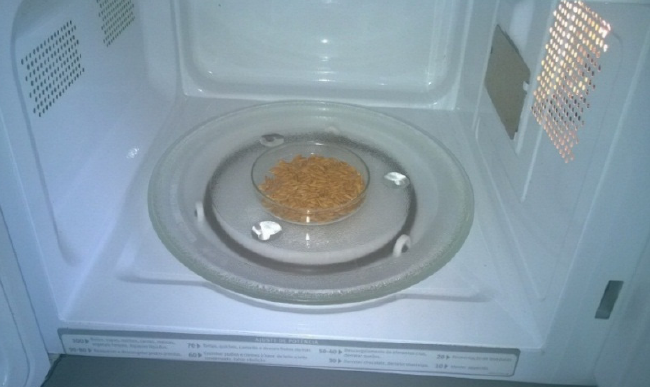
Figure 1. Sample positioned in the microwave oven to start drying.